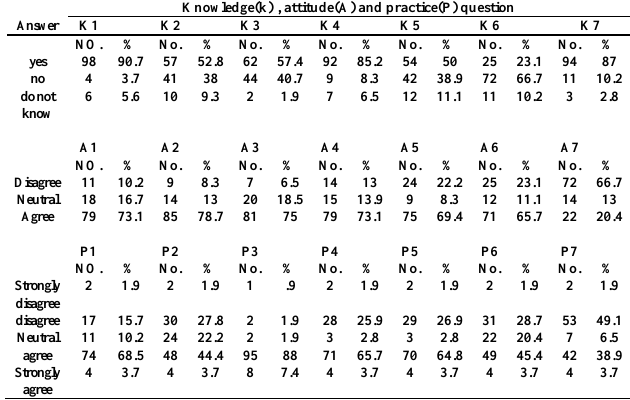
It was shown that participants’ attitude towards antibiotic use was not statistically associated with gender, age, qualification, current work, experience nor the Marital status. Table 4.